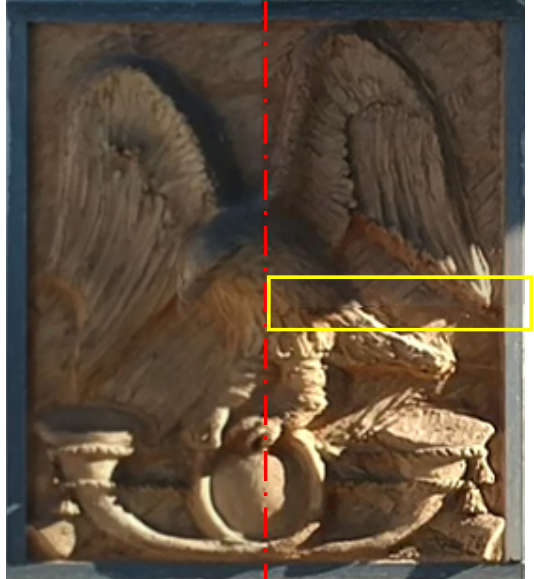
Figure 6. Orthophoto of the eagle’s high relief generated using Pix4D (left) and MicMac (right). In the yellow frame it is highlighted an issue with the radiometric equalization of MicMac. Table 5. Main specifications of the two employed laser scanners